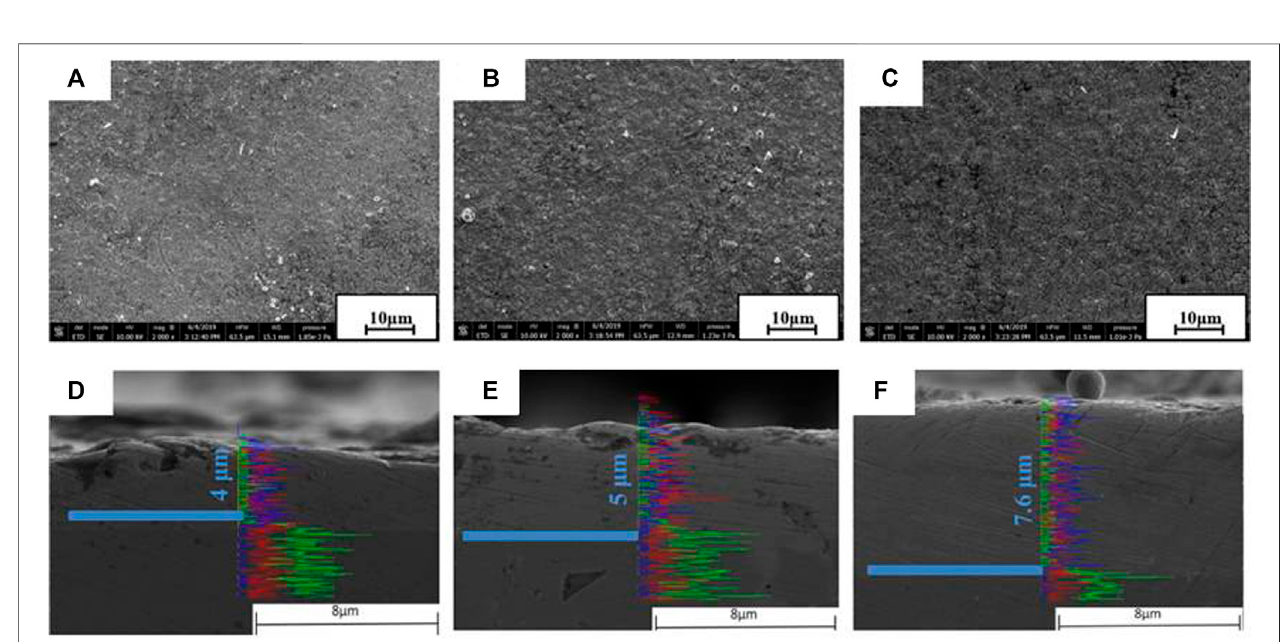
FIGURE 5 | Surface and cross-sectional morphology of Ni coatings in the different duty ratios [50% (A/D) ; 80% (B/E) ; 100% (C/F) ] before corrosion.